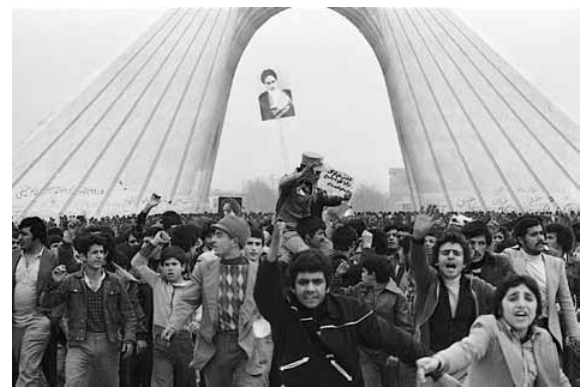
fig. 6. revolutionaries gathered at a massive demonstration in Tehran on feb.8, 1979. (npr.org